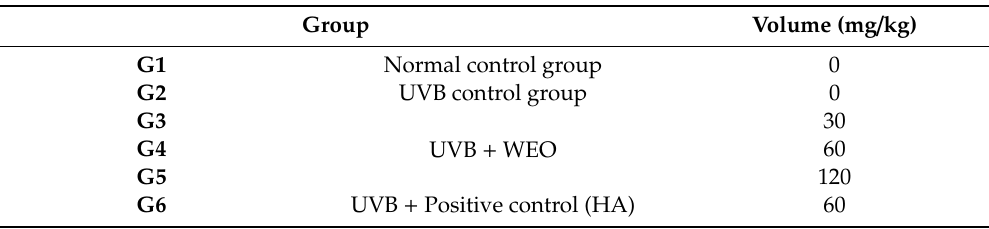
Table 1): normal control (NC) group, UVB group, UVB + WEO 30 group, UVB + WEO 60, UVB + WEO 120, and UVB + HA group. Test materials were administered orally via disposable oral gavage needles in the morning daily for 12 weeks. Table 1. Treatment groups. Group Volume (mg / kg) G1 Normal control group